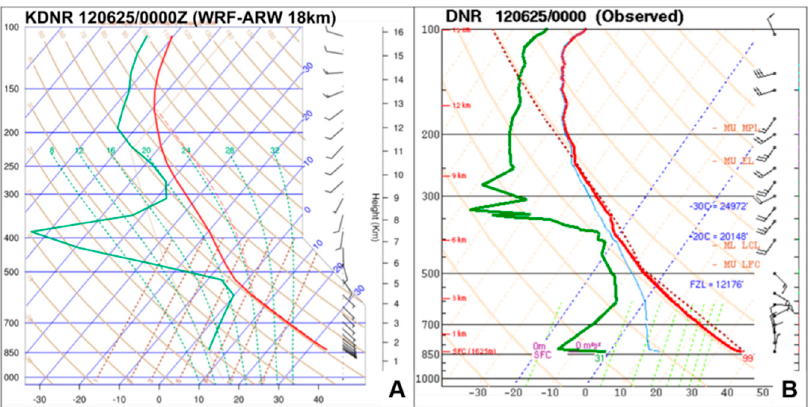
Figure 12. Comparison of the 00Z 25 June 2012 ( A ) WRF-ARW KDNR 18 km simulated upper air analysis and ( B ) observed KDNR upper air sounding.